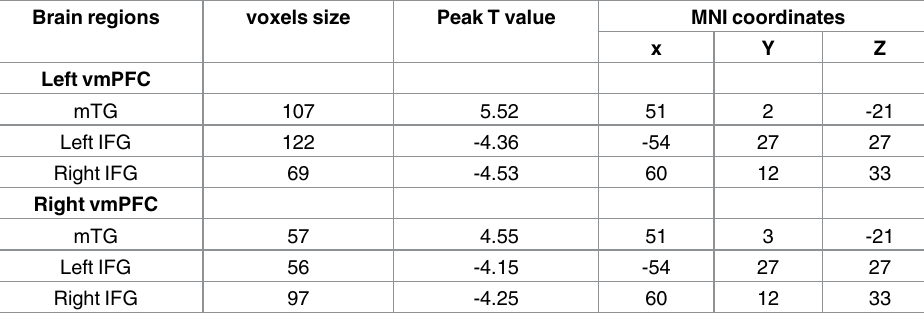
Table 3. The results of the functional connectivity. Brain